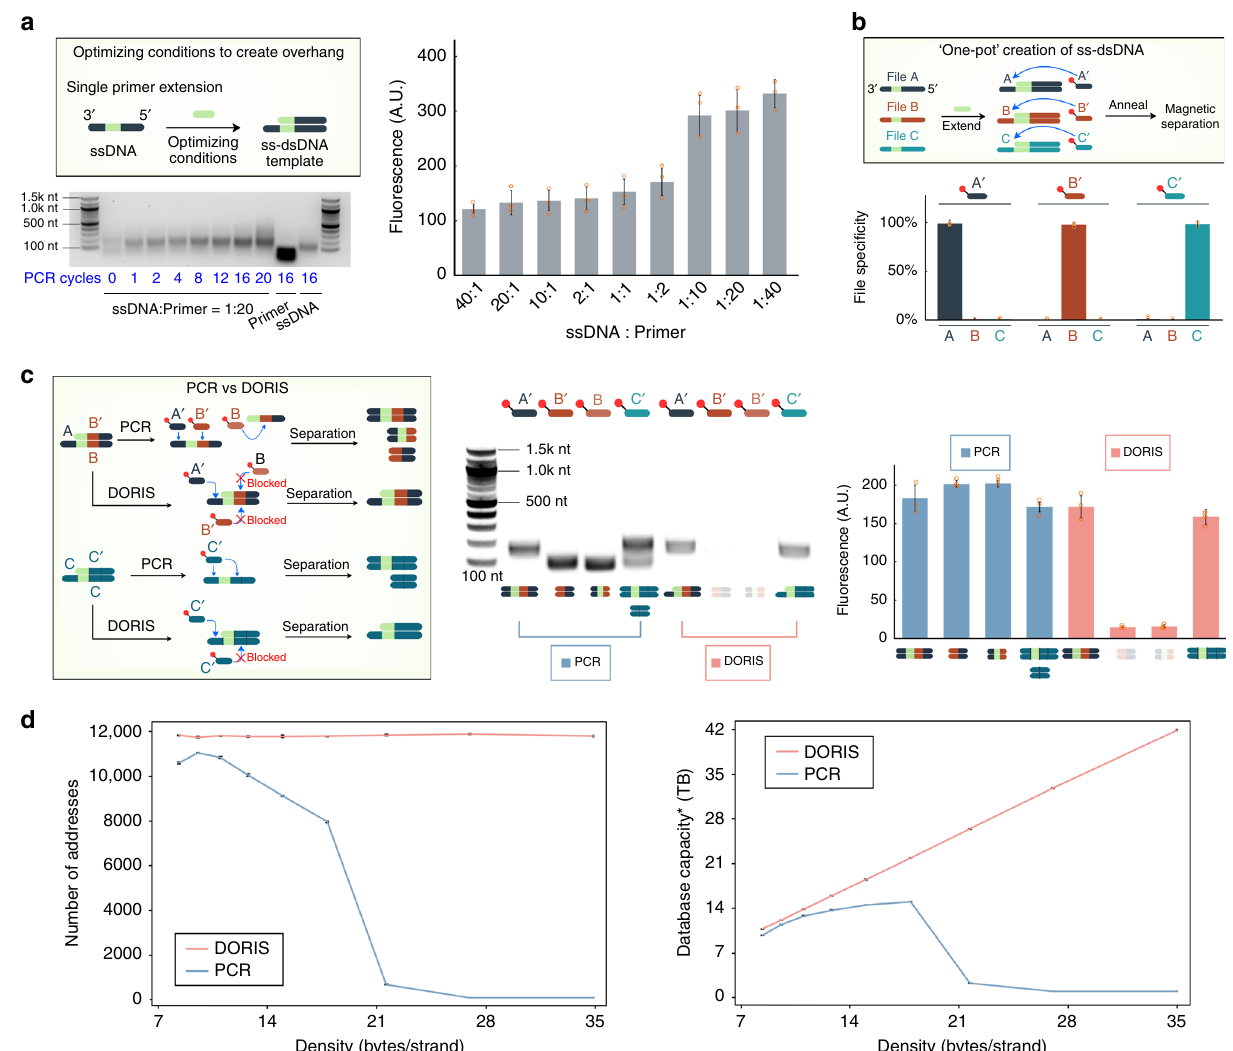
Fig. 2 DORIS eliminates non-speci fi c interactions and increases density and capacity limits. a Single primer extension created ss-dsDNAs. (Bottom) 4 cycles of PCR generated the optimal amount of 160 nt ss-dsDNAs while minimizing excess ssDNA production. (Right) DNA gel showed a marked increase in generation of ss-dsDNAs below 1:10 ssDNA:primer ratios. b Individual fi les can be separated from a three- fi le database created by a one-pot single primer extension. Each fi le was bound by its corresponding biotin-linked oligo, followed by a non-PCR-based separation using functionalized magnetic beads. File separation speci fi city is the percentage of the DNA separated by that is either fi le A, B, or C as measured by qPCR. c (Left) PCR but not DORIS will allow oligos to bind internal off-target sites and produce undesired products. (Middle) DNA gels and (Right) their quanti fi ed fl uorescence (blue for PCR, pink for DORIS) showed that PCR-based access resulted in truncated and undesired amplicons whereas DORIS accessed only the desired strands. d (Left) Monte Carlo simulations estimated the number of oligos found that will not interact with each other or the data payload. 400,000 oligos were tested against different density encodings. The x -axis represents density (Eq. (4)), which is inversely related to the length of codewords used to store discrete one-byte data values. We evaluated codeword lengths of 12 through 4. For DORIS, the encoding density was not impacted because it need not guard against undesired binding between the oligos and data payloads. (Right) For PCR, the number of oligos that will not bind the data payload drops as strand density increases, which means that fewer fi les can be stored, leading to a lower overall system capacity. For DORIS, the availability of oligos is independent of encoding, and capacity therefore increases with denser encodings. Plotted values represent the arithmetic mean, and error bars represent the s.d., of three replicate fi le separations or simulations. Gel images are representative of three independent experiments measured by RT-QPCR. Source data are provided as a Source Data fi le. *Capacities may be limited by synthesis and sequencing limitations not accounted for